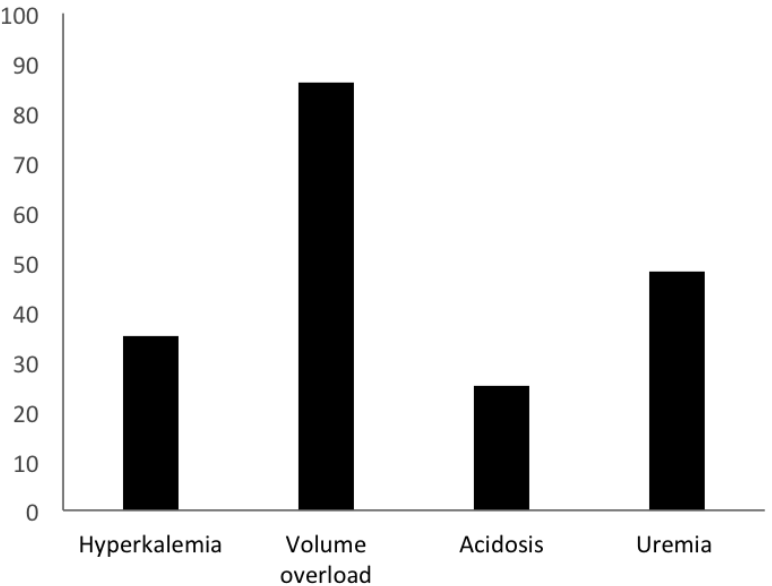
Figure 2. Indications for initiation of hemodialysis ( n = 80). Legend: Percentage of patients with a particular indication for initiation of hemodialysis. Fifty-one patients (64%) had two or more indications present. Table 3. Selected iatrogenic medications and contrast exposure after Acute Kidney Injury.